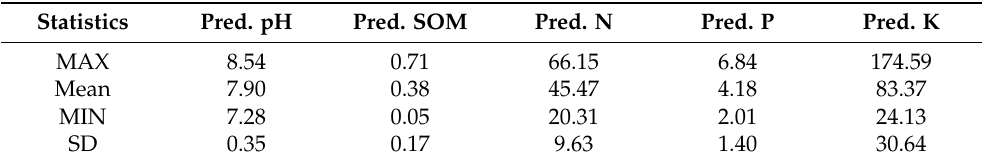
Table 5. Statistics of predicted SFC parameters based on the S2A image.